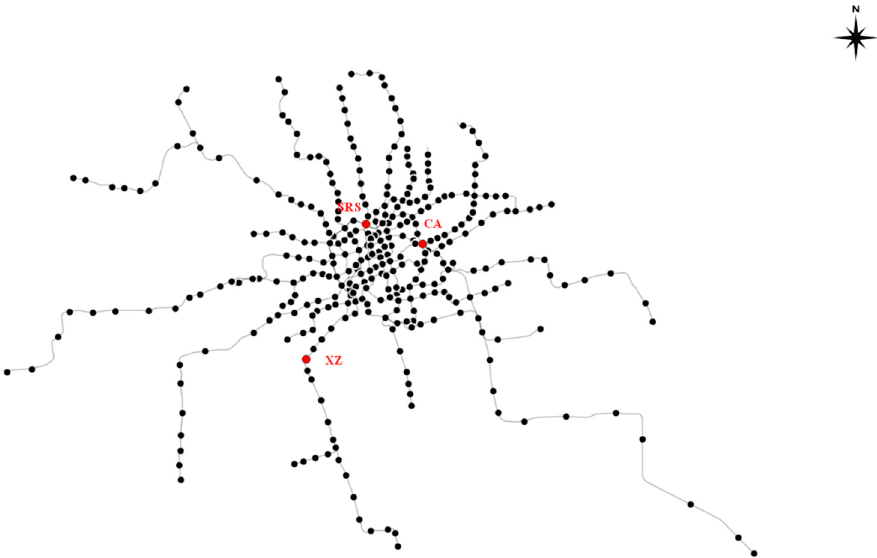
Figure 1. Topological network of Shanghai metro system. Table 1. A sample AFC data.